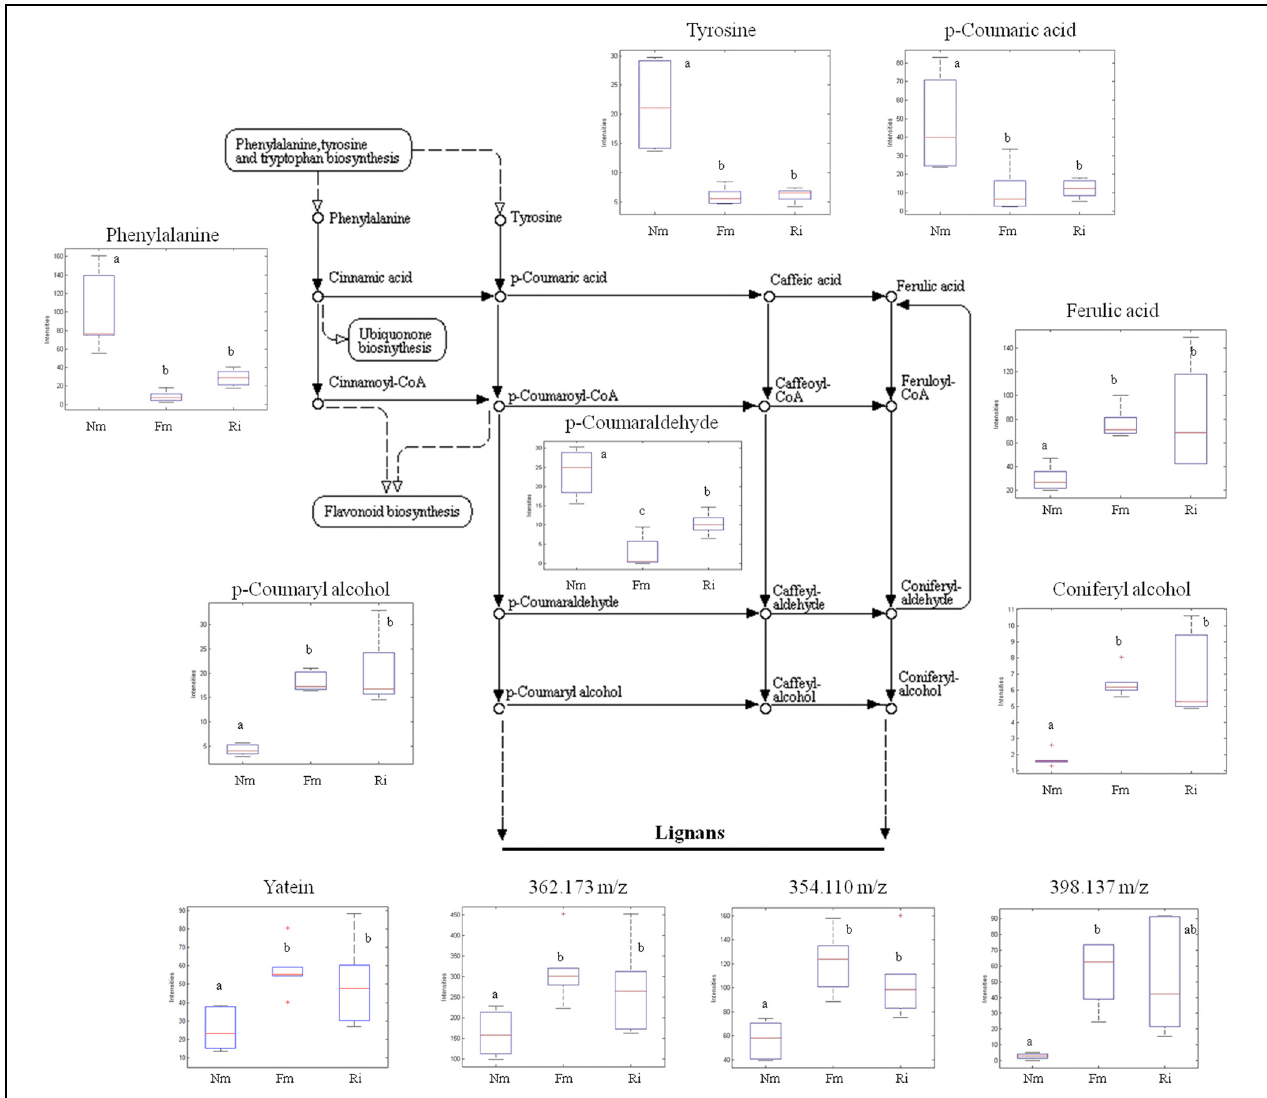
FIGURE 4 | Profile of selected metabolites from the phenylpropanoid, lignin, and lignan biosynthetic pathways. Non-mycorrhizal roots (Nm), and roots colonized by F. mosseae (Fm) and R. irregularis (Ri) were processed for relative quantification analysis by HPLC–QTOF MS. The metabolite concentration in each sample was determined by normalizing the chromatographic area for each compound with the dry weight of the